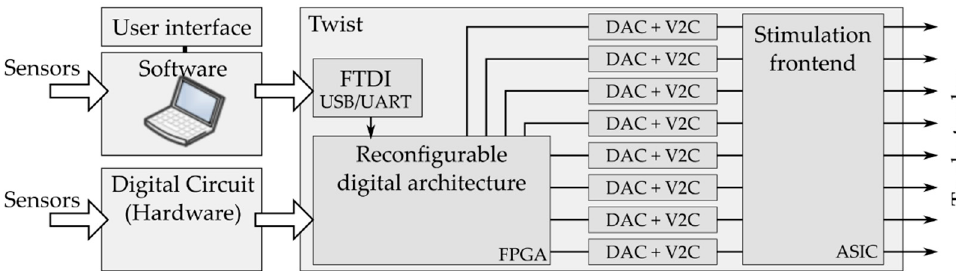
Figure 3. System-level architecture of TWIST: The system can drive up to 8 electrodes in parallel, the stimulation currents are high voltage compliant and generated by an ASIC. The ASIC receives its input from 8 parallel Digital to Analog converters (DAC) and associated voltage-to-current converter (V2C, low voltage). A dedicated digital architecture is implemented on an FPGA. This architecture can be controlled by other circuits or by a software user-interface, using a FTDI for USB connection.